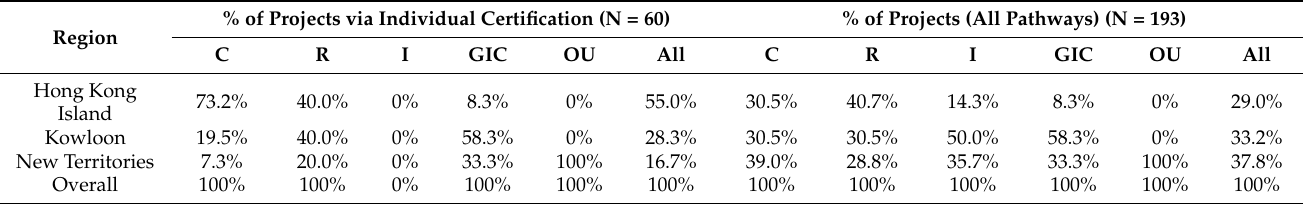
Table 8. Breakdowns of BEAM-certified projects by building uses and regions.